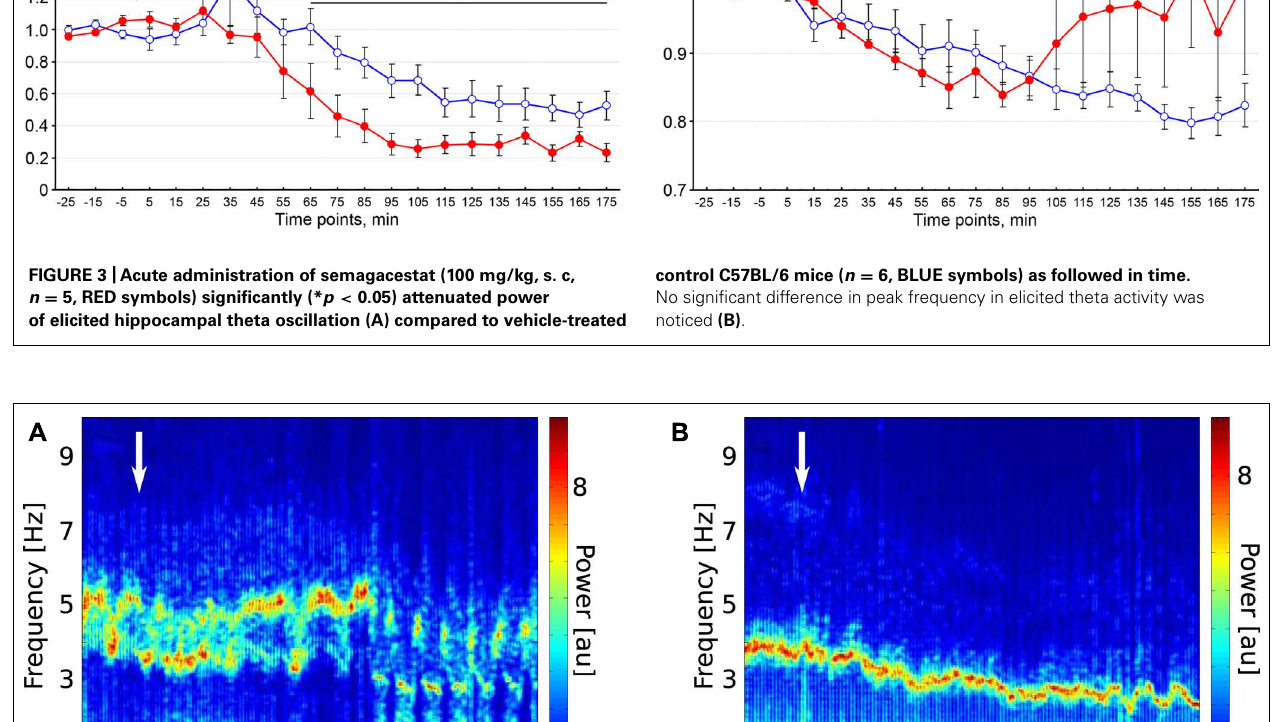
FIGURE 3 |Acute administration of semagacestat (100 mg/kg, s. c, n = 5, RED symbols) significantly (* p < 0.05) attenuated power of elicited hippocampal theta oscillation (A) compared to vehicle-treated